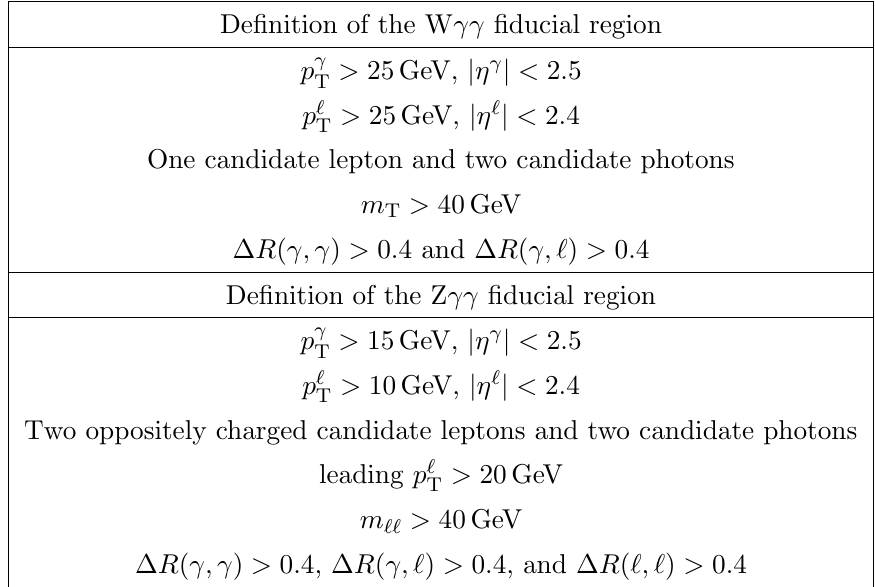
Table 2 . Fiducial region de(cid:12)nitions for the W (cid:13)(cid:13) analysis (upper) and Z (cid:13)(cid:13) analysis (lower). The transverse mass m T is de(cid:12)ned as in the event selection, but with p miss transverse momentum.